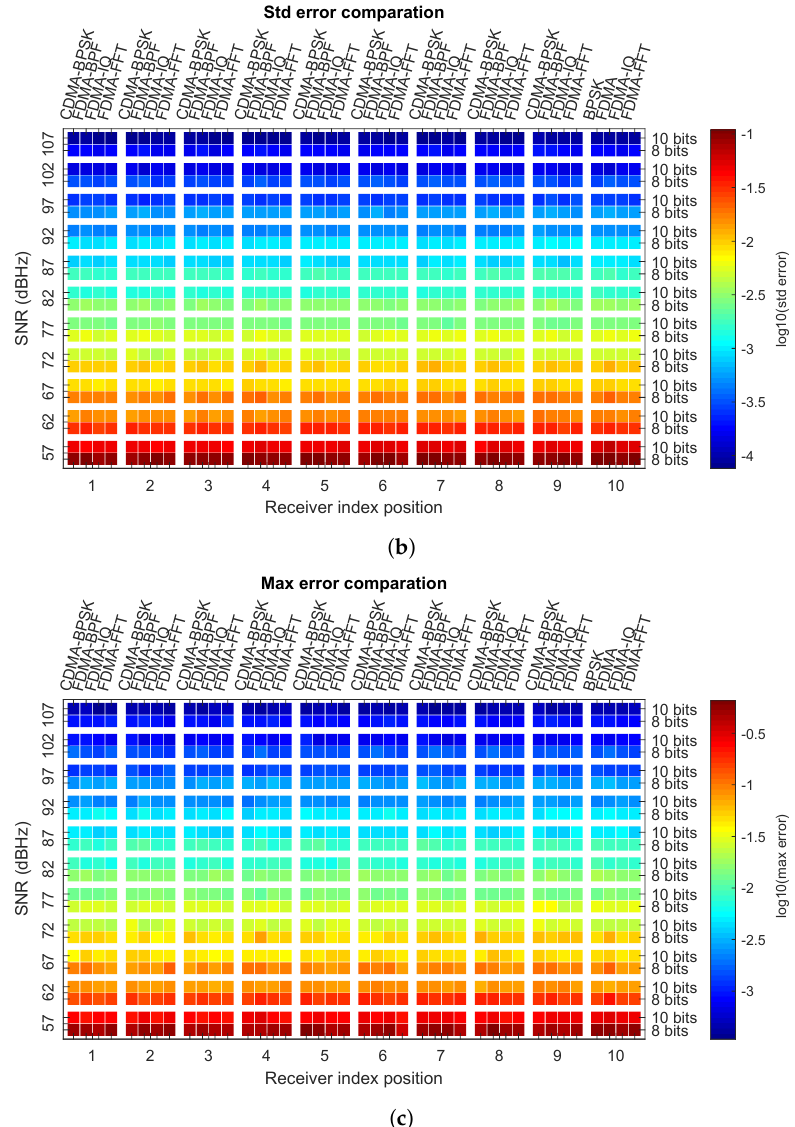
Figure A1. Comparison of the error in the calculation of the impact point as a function of the SNR, position of the receiver, technique used, and signal size: ( a ) mean error; ( b ) standard deviation error; and ( c ) maximum